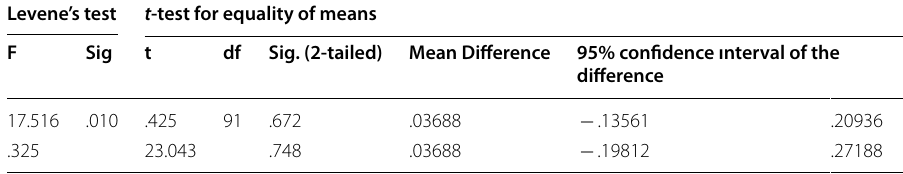
Table 7 Independent sample T -test (gender) Levene’s